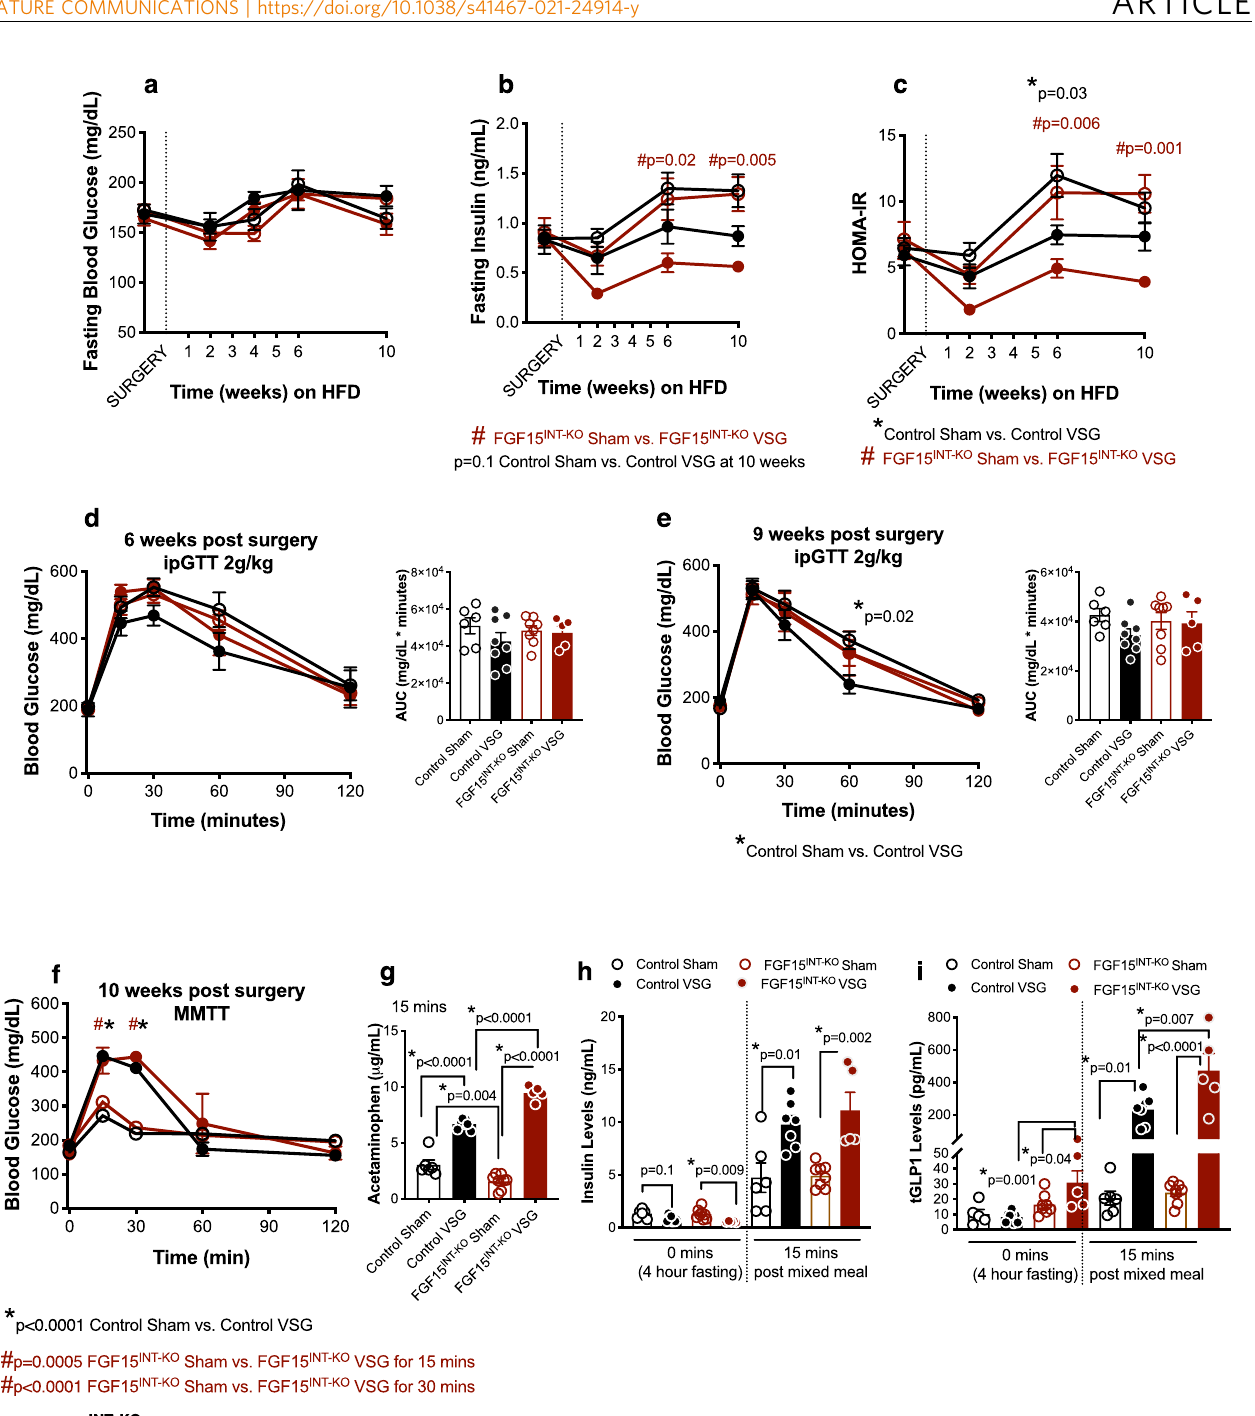
Fig. 4 FGF15 INT-KO mice remain glucose intolerant despite signi fi cant body weight loss after VSG. a Fasting (4h) blood glucose, b fasting (4h) insulin levels and c HOMA-IR after surgery. d Intraperitoneal glucose tolerance test (ipGTT; 2g/kg) performed 6-weeks post-surgery and Area Under the Curve (AUC). e Intraperitoneal glucose tolerance test (ipGTT; 2g/kg) performed 9 weeks post-surgery and Area Under the Curve (AUC). f Mixed meal tolerance test (MMTT) performed 10 weeks post-surgery. g Gastric emptying rate measured by acetaminophen levels at 15min post mixed meal. h Insulin levels at baseline (4h fast) and 15min post mixed meal. i Total GLP-1 levels at baseline (4h fast) and 15min post mixed meal. Animal number ( a – f ) and ( h , i ): Control Sham ( n = 6), Control VSG ( n = 8), FGF15 INT-KO Sham ( n = 8), FGF15 INT-KO VSG ( n = 5). Animal number g: Control Sham ( n = 6), Control VSG ( n = 7), FGF15 INT-KO Sham ( n = 8), FGF15 INT-KO VSG ( n = 5). Data are shown as means±SEM. * p <0.05 (two-way ANOVA with Tukey ’ s post hoc fatty acids in both VSG groups compared to Sham controls Analysis of hepatic lipids revealed an increased cholesterol and (Fig. 5i). Surprisingly, the cholesterol synthesis rate-limiting esteri fi ed cholesterol levels in FGF15 INT-KO VSG mice (Fig. 5f, g). gene, 3-hydroxy-3-methyl-glutaryl-glutaryl-coenzyme A reductase, Hepatic triacylglycerols were decreased in Control VSG com- Hmg-CoA reductase ( Hmcgr ), was upregulated in FGF15 INT-KO pared to Control Sham mice, but remained at similar levels Sham compared to Control Sham mice, but reduced after VSG in between FGF15 INT-KO Sham and FGF15 INT-KO VSG mice (Fig. 5h). There was a trend toward decreased hepatic free FGF15 INT-KO VSG mice (Fig. 5j). Next, we measured the